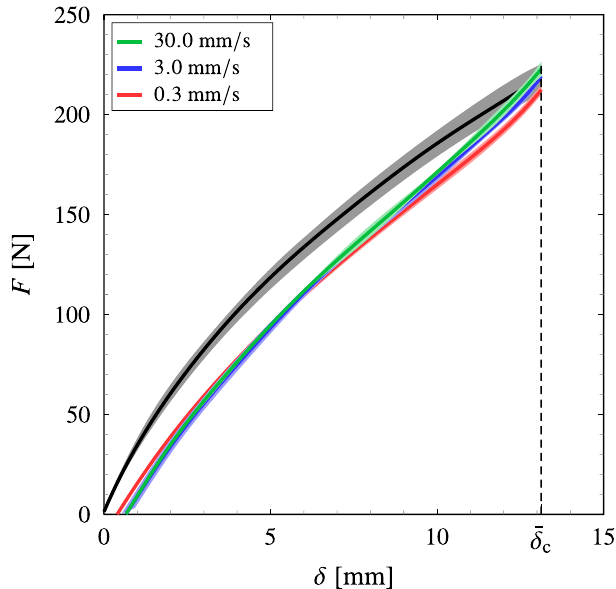
Figure 8. The load–displacement curves of uncracked pure-shear specimens at loading rate of 0.3 mm / s ( 0.01 s − 1 ) and different unloading rates. The red, blue and green lines represent the unloading rates of 0.3 , 3.0 , and 30.0 mm / s (i.e. 0.01 , 0.1 , and 1.0 s − 1 ), respectively, and fill areas represent the experiment scatter (error bars). The unloading point is taken at ¯ δ c = 13.131 mm .